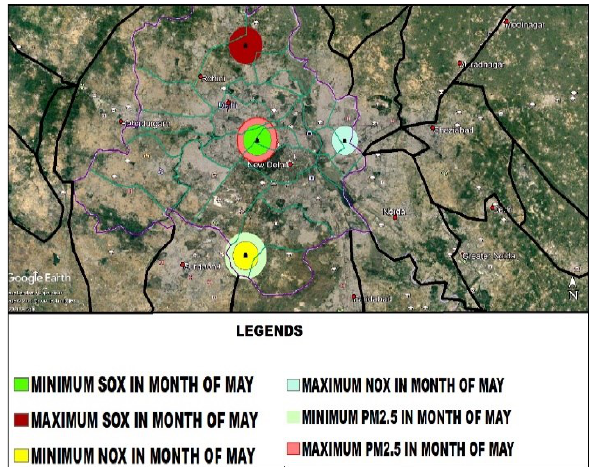
Figure 19. Air quality map of Delhi depicting maximum and minimum value recorded in a different area of Pm2.5, NOx, and SOx in the month of May(µg/m 3 ).